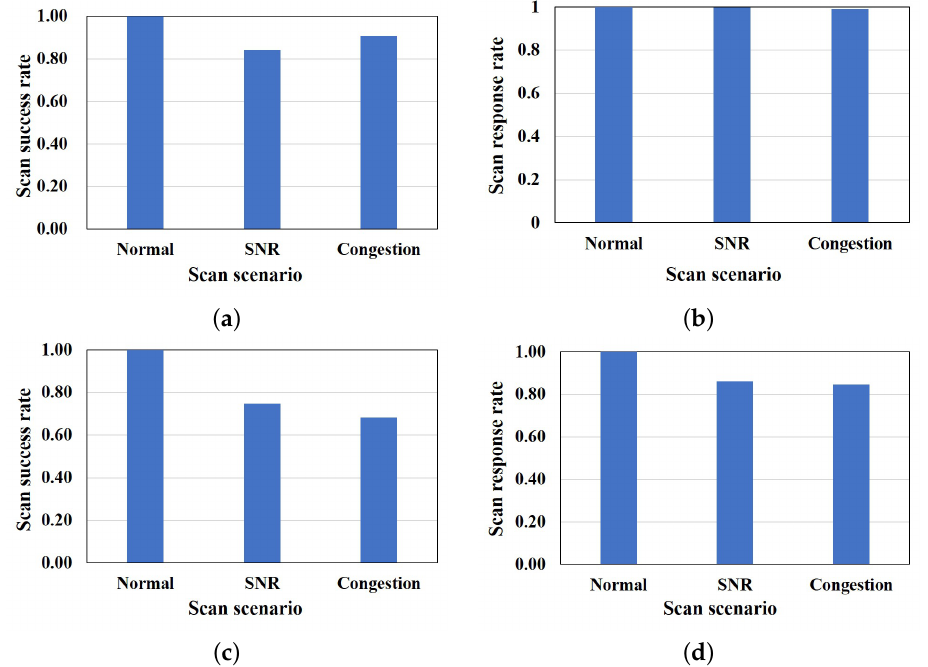
Figure 5. Network scan response analysis. Set 1: ( a ) Network scan success rate; ( b ) network scan response rate. Set 2: ( c ) Network scan success rate; ( d ) network scan response